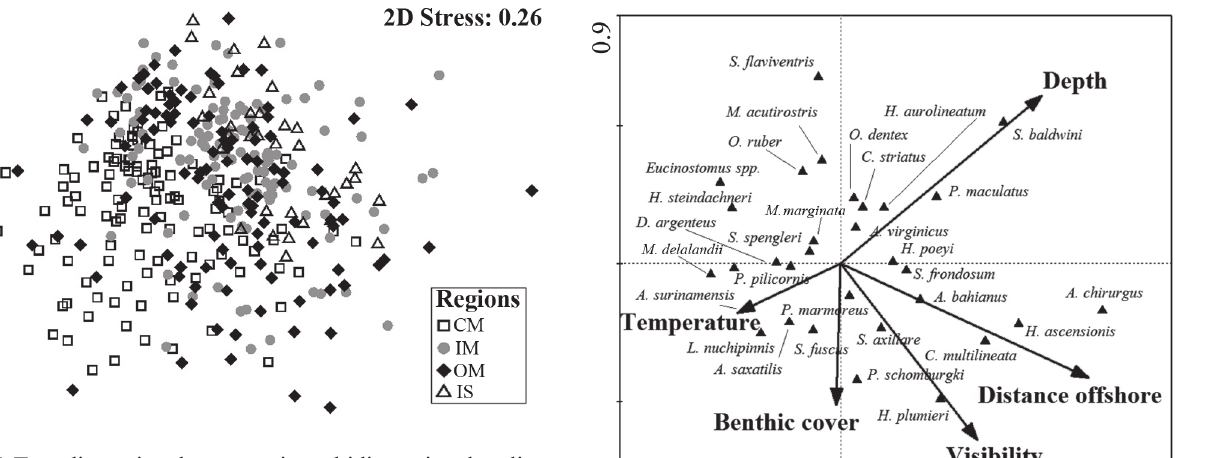
Fig. 5. Two-dimensional non-metric multidimensional scaling plot (NMDS) with all samples from all strata: (1) Continental Margin - CM, (2) Insular Margin - IM, (3) Outer Margin - OM, and (4) Islands - IS (Alcatrazes, Búzios and Vitória). Notice the clear discrimination between samples from Continental Margin (CM - open squares) vs. Islands (IS - open triangles).